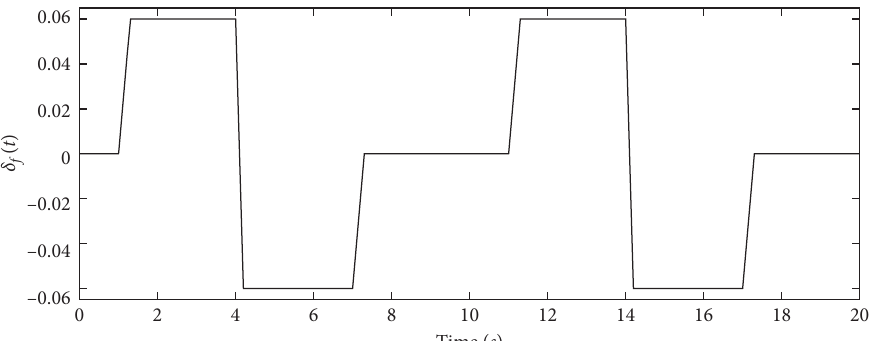
Figure 3: Profile of the steering angle given by driver δ Table 2 [28].